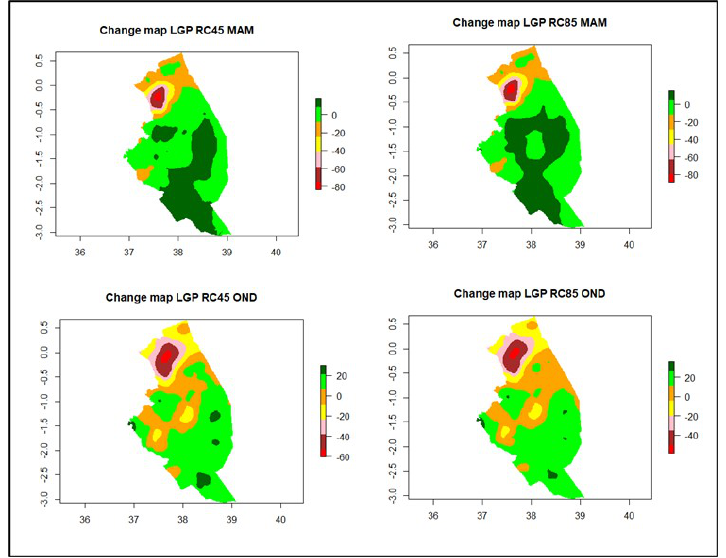
Figure 4. Potential evapotranspiration and change across the seasons and epochs.